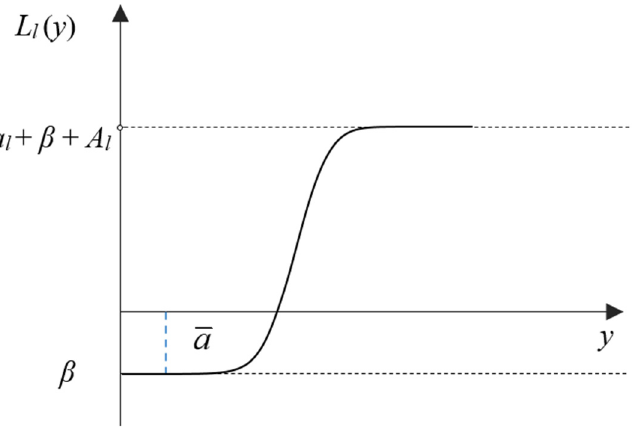
Figure 7. Curve of grey quality gain–loss function with smaller-the-better characteristics (hyperbolic tangent compensation).